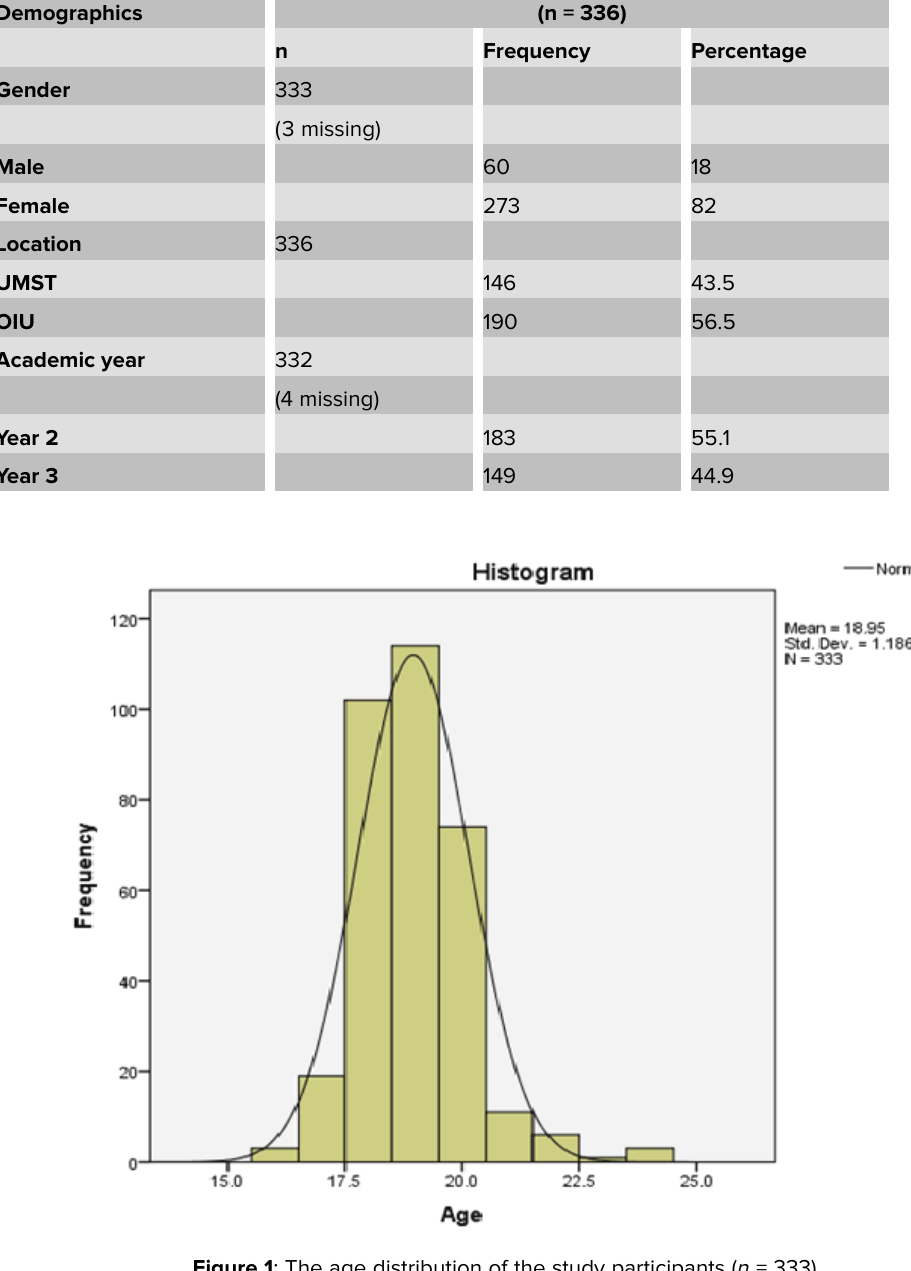
Figure 1 : The age distribution of the study participants ( n =